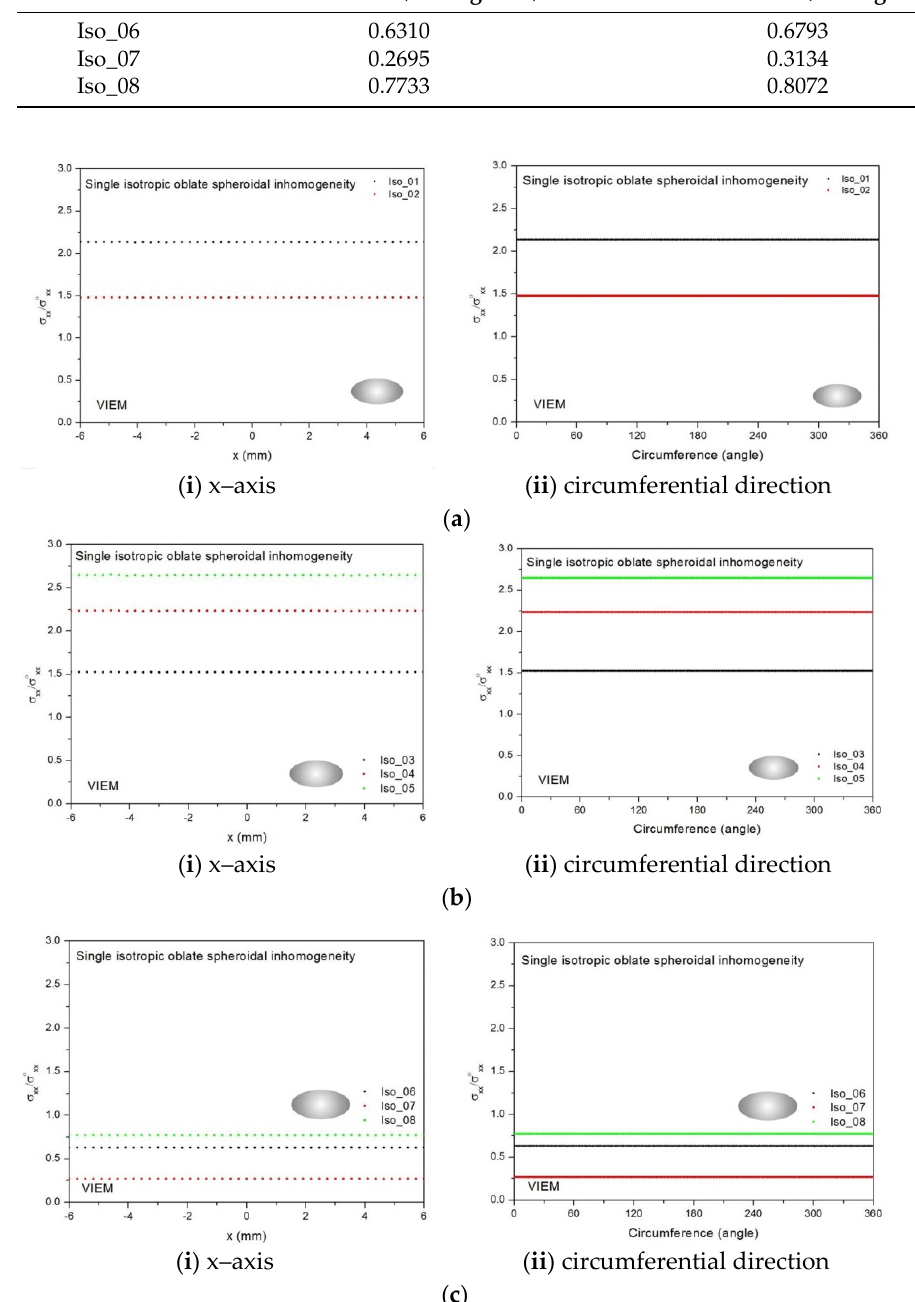
Figure 18. VIEM results for the normalized tensile stress component ( σ xx / σ oxx ) along ( i ) the x–axis inside and ( ii ) the circumferential direction of the isotropic oblate spheroidal inclusions with b/a = c/a = 0.5 (a = 6 mm) under uniform remote tensile loading. ( a ) Iso_01 and Iso_02. ( b ) Iso_03, Iso_04 and Iso_05. ( c ) Iso_06, Iso_07 and Iso_08.